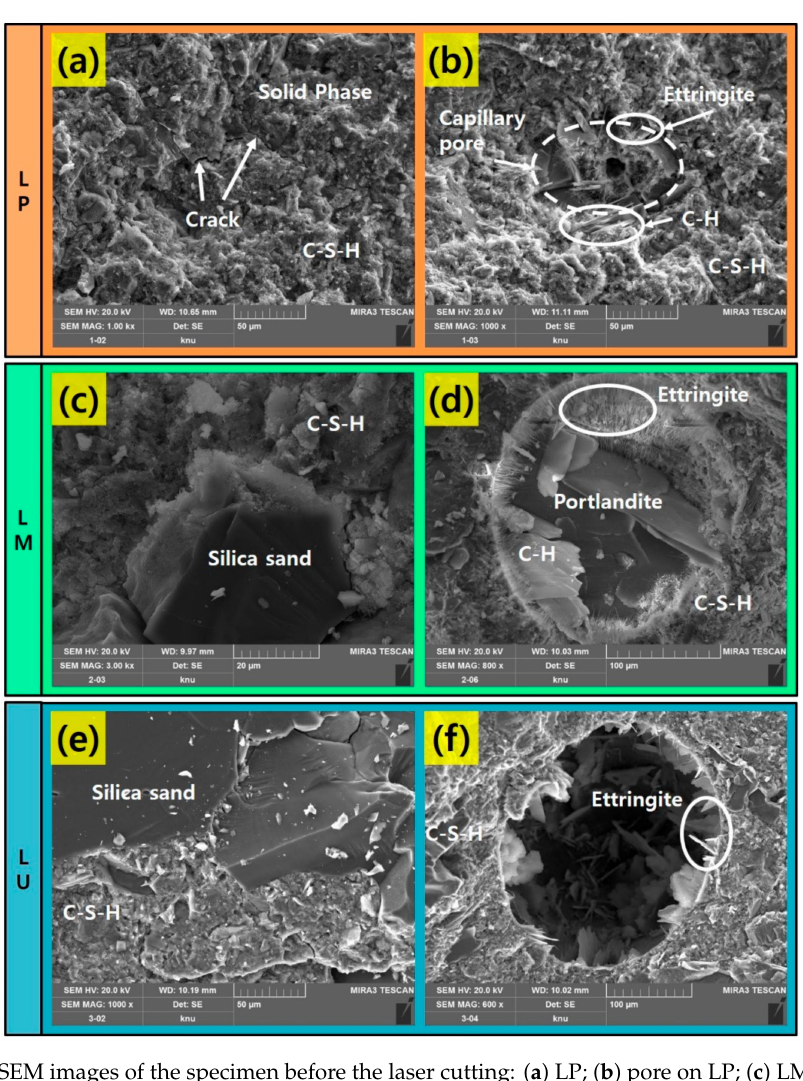
Figure 2. SEM images of the specimen before the laser cutting: ( a ) LP; ( b ) pore on LP; ( c ) LM; ( d ) pore on LM; ( e ) LU and ( f ) pore on LU.